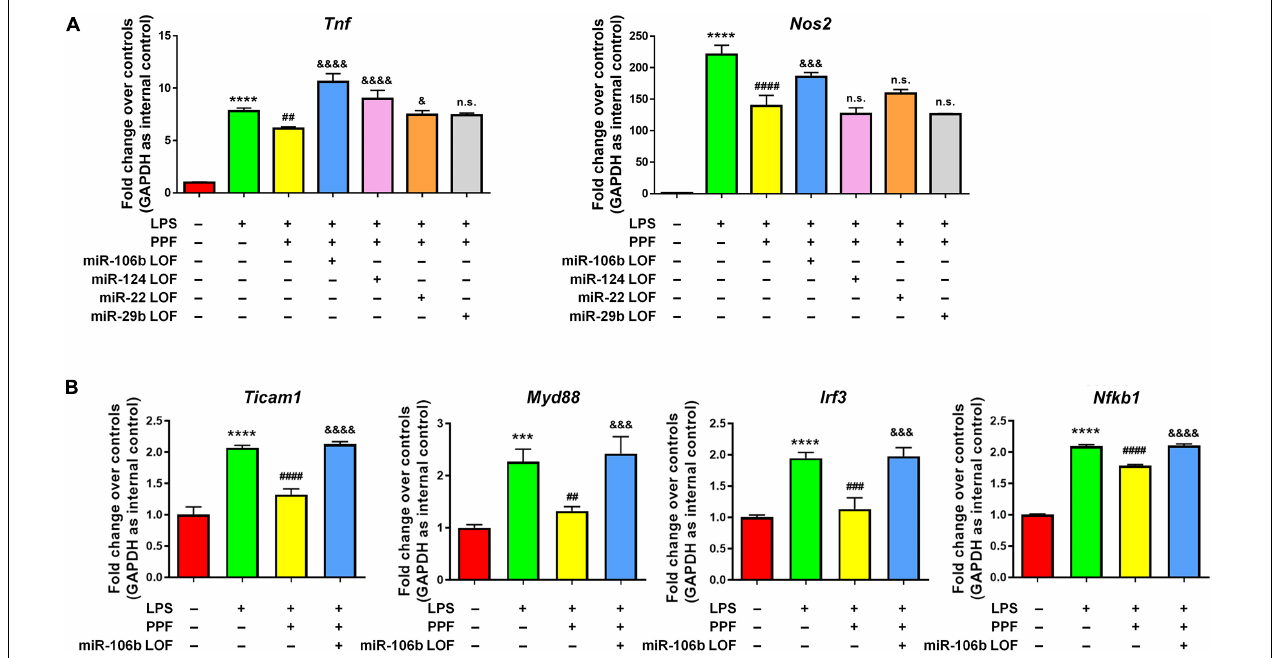
FIGURE 3 | miR-106b mediates the anti-inflammatory effects of propofol. Primary mouse microglia were stimulated by LPS, followed by propofol treatment and the transfection of either miR-106b, miR-124, miR-22, or miR-29b inhibitors for 2 days. (A) The transcript levels of pro-inflammatory genes Tnf and Nos2 in microglia were determined by qRT-PCR. (B) The transcript levels of NF- κ B signaling component genes Ticam1 , Myd88 , Irf3 , and Nfkb1 in microglia were determined by qRT-PCR. Data were represented as mean ± SD from three independent experiments. The symbols *** and **** denote p < 0.001 and p < 0.0001, respectively, in comparison with control group. The symbols ## , ### , and #### denote p < 0.01, p < 0.001, and p < 0.0001, respectively, in comparison with LPS group. The symbols & , &&& , and &&&& denote p < 0.05, p < 0.001, and p < 0.0001, respectively, in comparison with LPS + PPF group. PPF, propofol. n.s. denotes